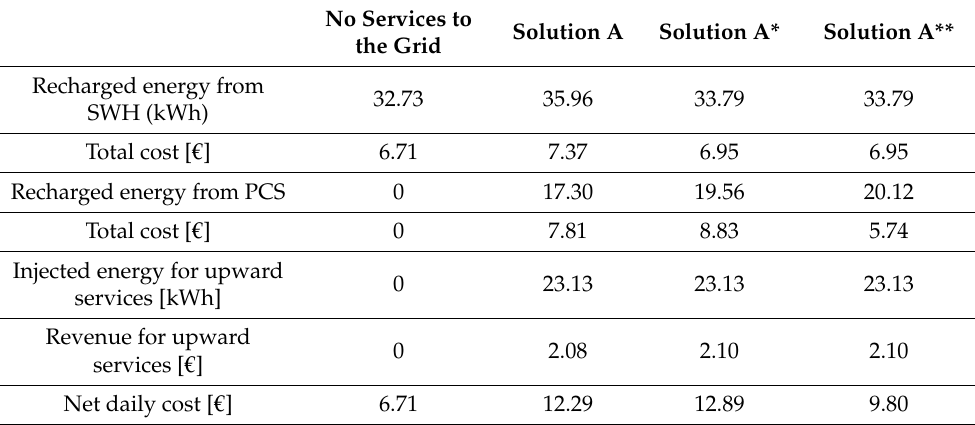
Table 20. Results of different solutions for mobility pattern